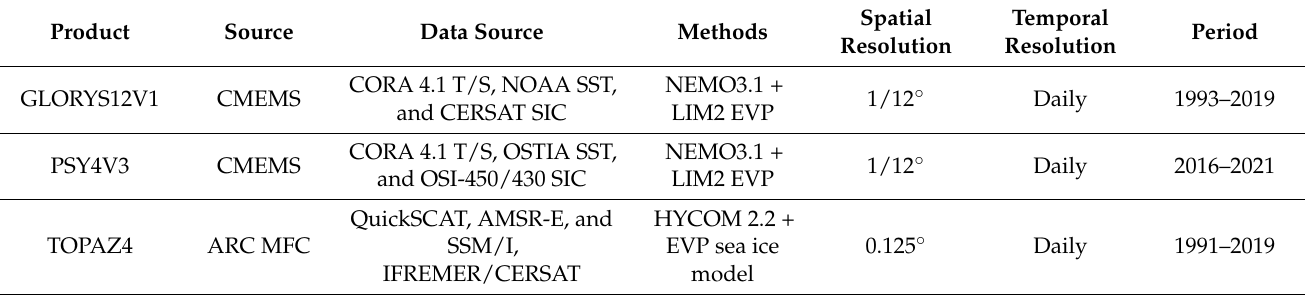
Table 1. Basic specifics of the three sea ice motion products assessed in this